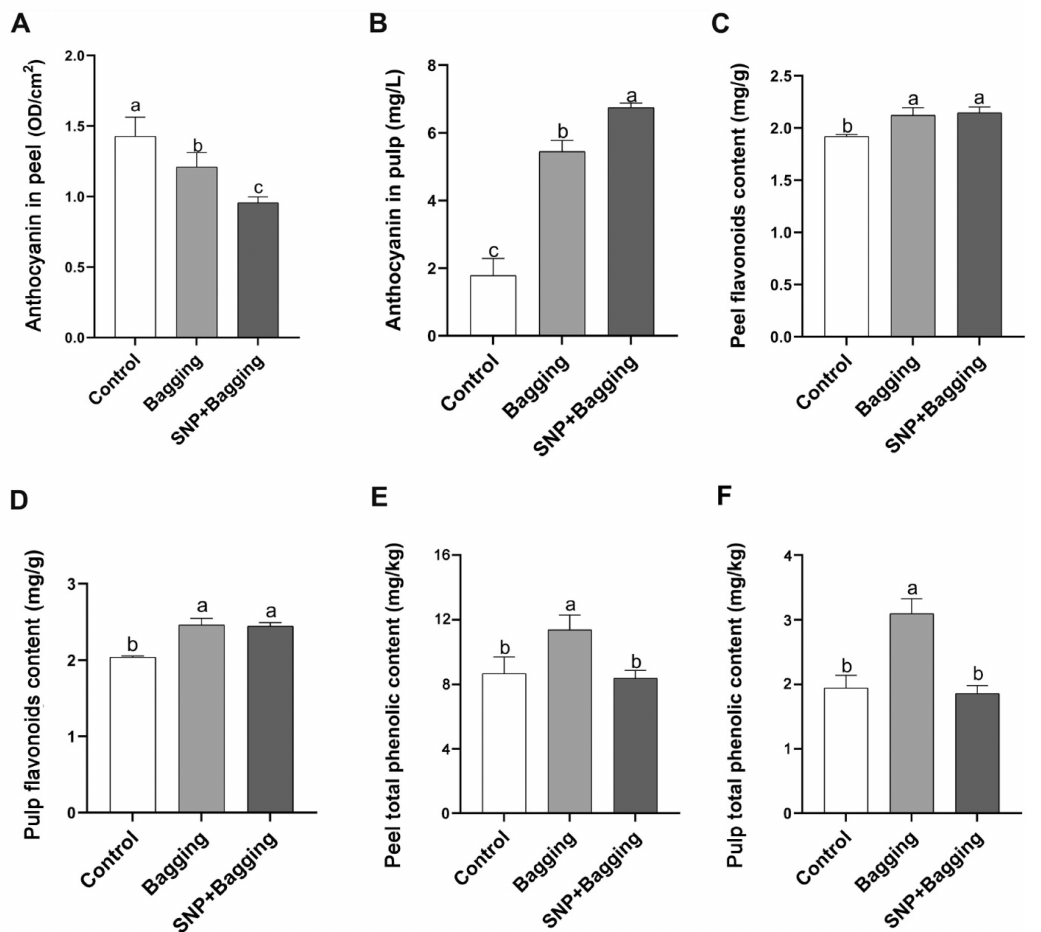
Figure 8. Effects of different treatments on peel anthocyanin content ( A ), pulp anthocyanin content ( B ), peel flavonoids content ( C ), pulp flavonoids content ( D ), peel total phenolic content ( E ), and pulp total phenolic content ( F ) of blood orange. Error bars show standard deviations ( n = 3). Different lowercase letters indicate significant differences at 0.05 ( p < 0.05) levels.